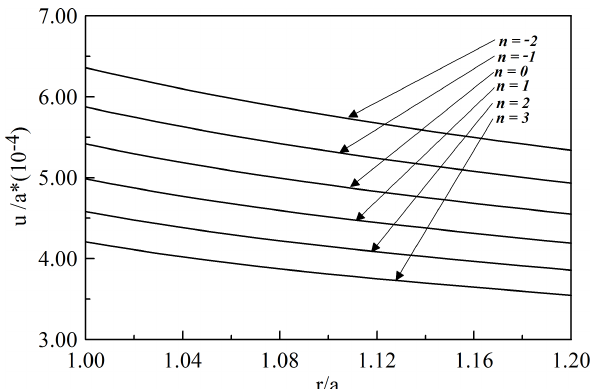
Figure 22: Radially distributed displacement